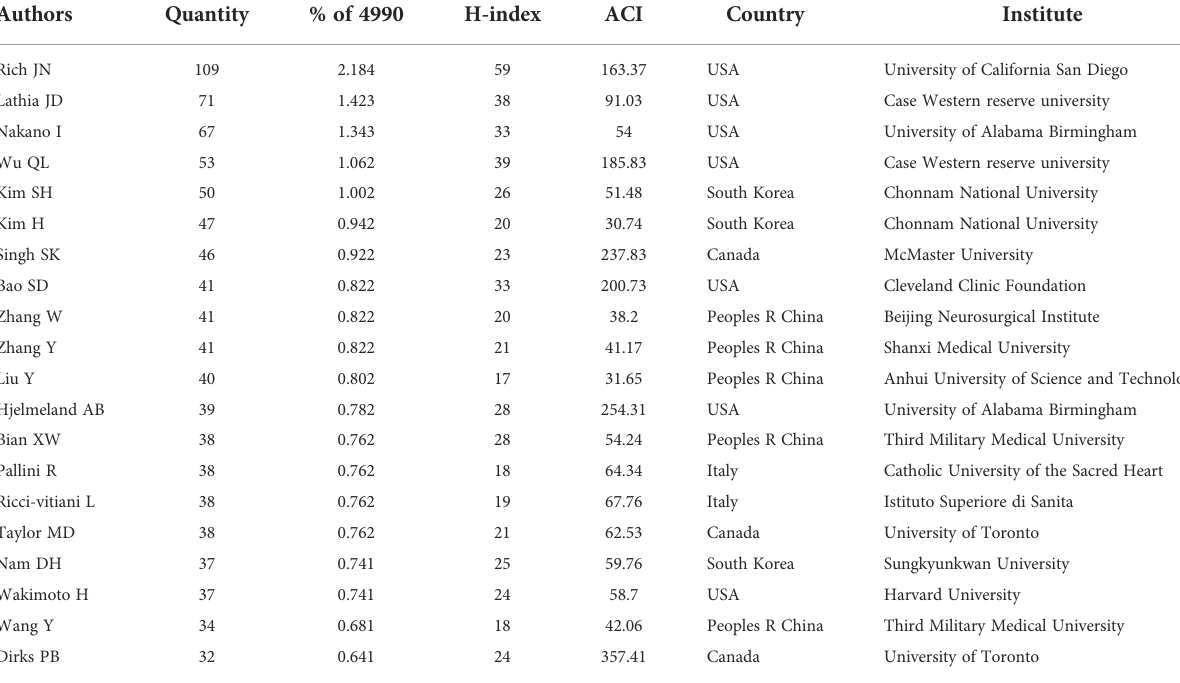
TABLE 5 The top 20 authors contributing the greatest amount to glioma stem